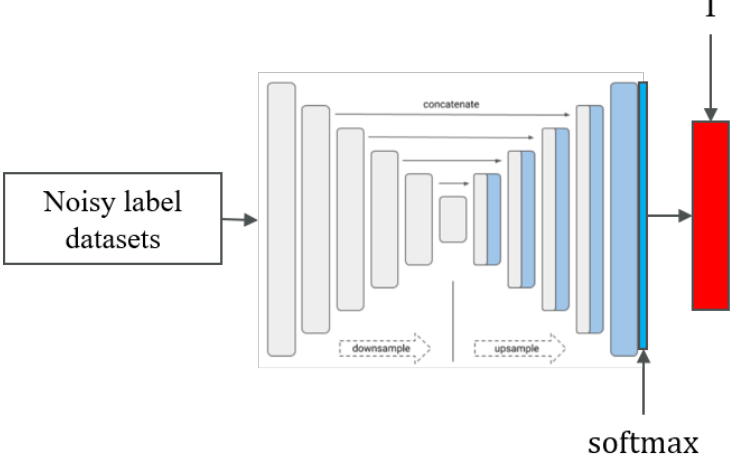
Figure 5. The main flowchart of T-revision.